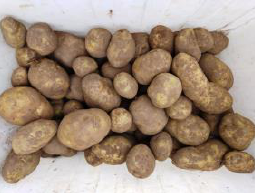
Figure 5. Test object of immersion cleaning.